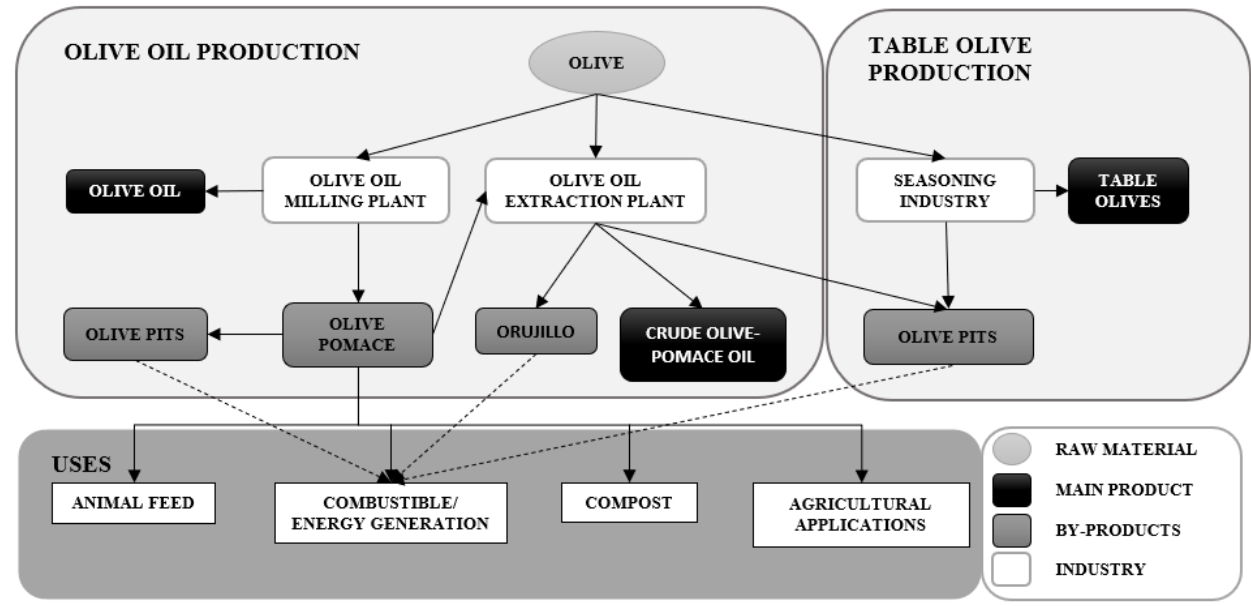
Figure 1. Simplified scheme of the processes involved in the production of olive oil and its by-products.